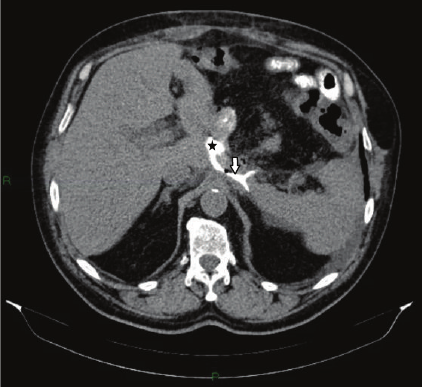
Figure 1: Axial contrast-enhanced abdominal computer tomography (CT): esophageal lumen (star); esophagojejunal anastomotic fistula